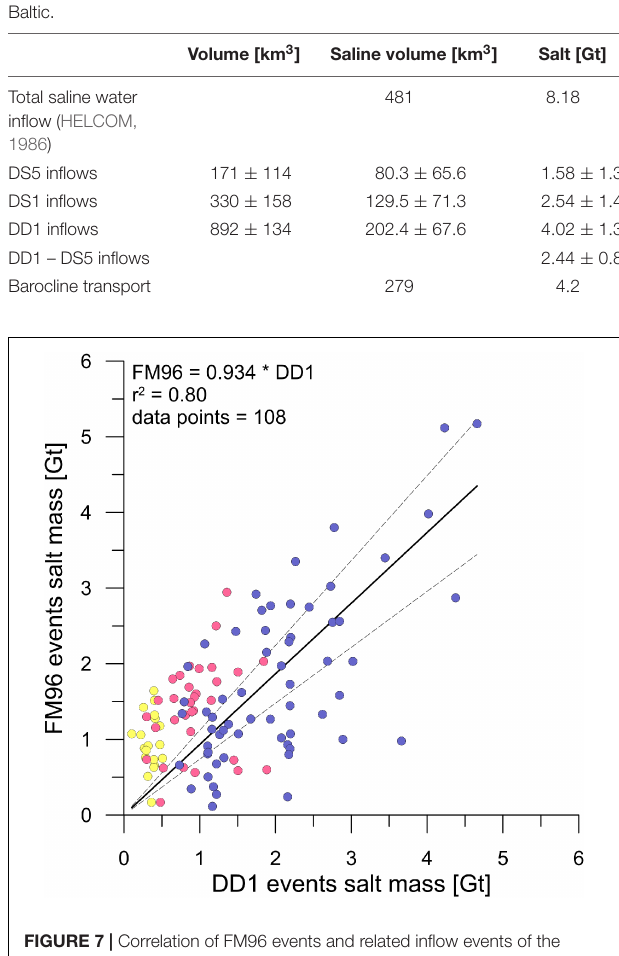
of barotropic inflows (DS5) is most similar to the classical